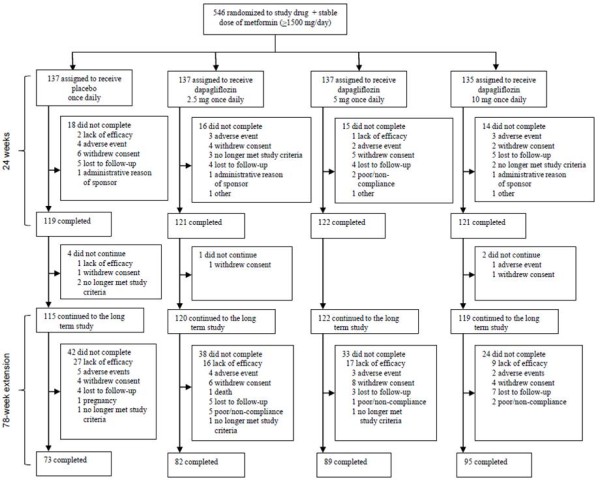
Trial profile over 102 weeks.